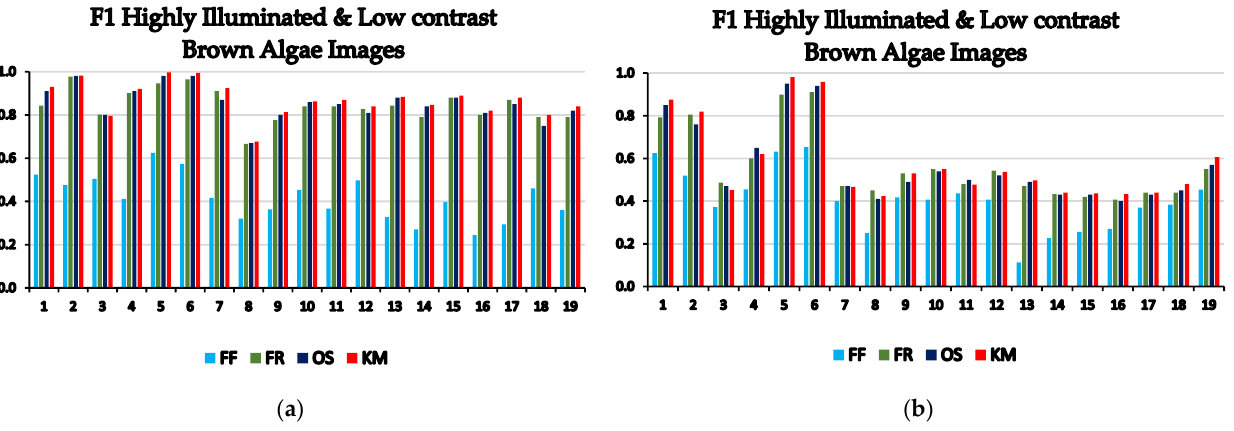
Figure 9. The results of evaluating the tested segmentation algorithms using highly illuminated and low contrast brown algae images. Images (1–10) had two categories, and (11–19) had three categories: ( a ) F1-score; ( b ) IOU.